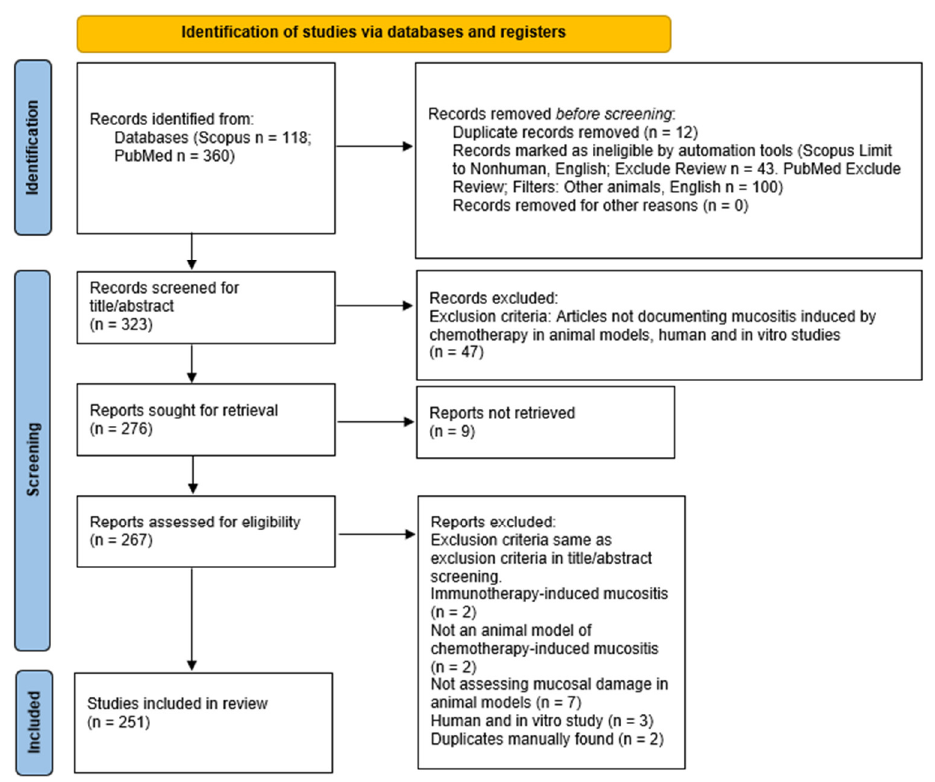
Figure 1. Flowchart of the data collection and selection process in accordance with PRISMA-ScR guidelines.